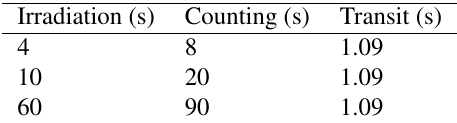
Table 1. Cycle times for irradition of 238 U with 4.6-MeV neutrons. Note that the transition time refers to the time travelling between the irradiation and counting